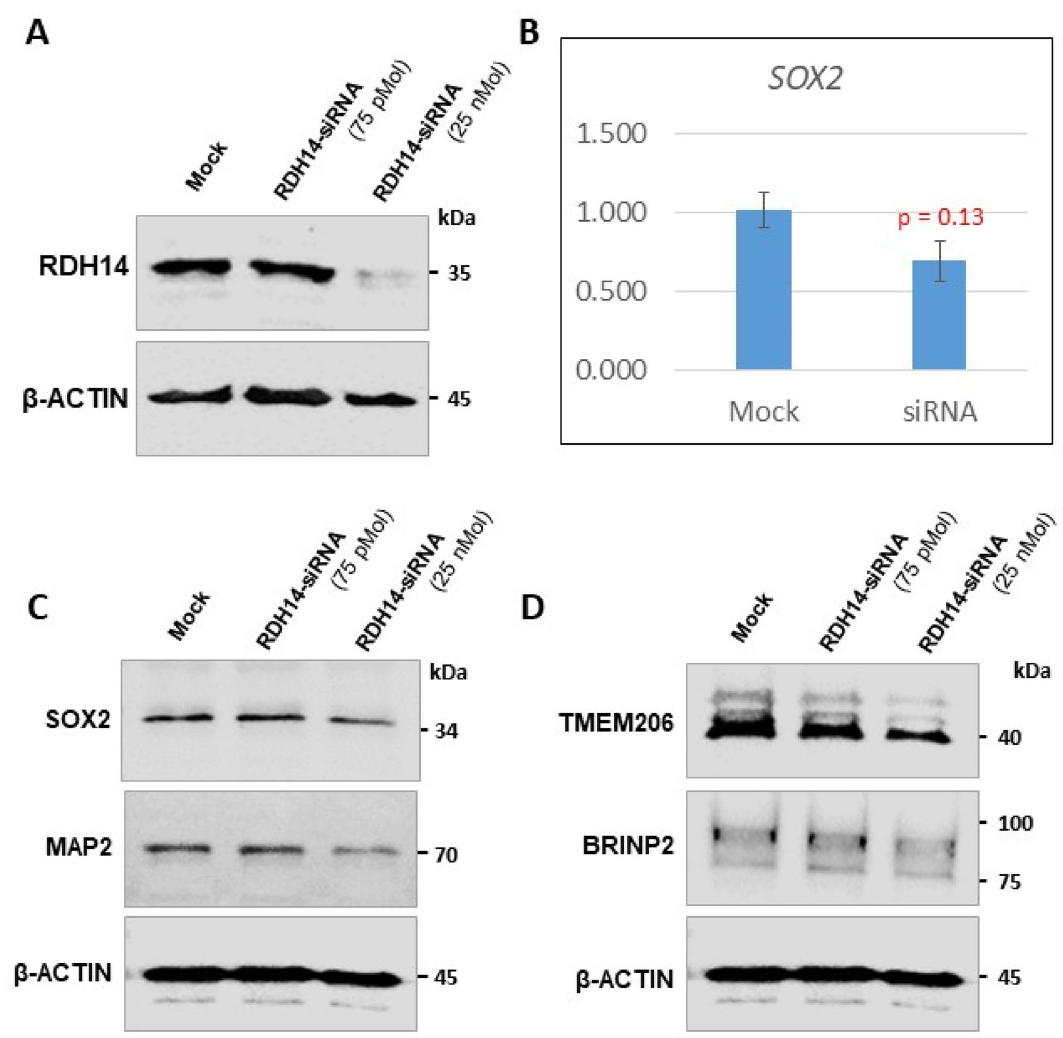
Figure 4. Analysis of the RDH14 knock down effects on SOX2, MAP2, TMEM206 (PACC1) and BRINP2 (FAM5B) in SK-N-SH cells. ( A ) Western blot analysis of the RDH14-siRNA transfection showing knock down of RDH14 protein, using anti-RDH14 rabbit polyclonal antibody (1:1000 dilution; cat# HPA056686; Atlas Antibodies, Bromma, Sweden). ( B ) qRT-PCR showing effect of RDH14-siRNA on transcription of SOX2 in SK-N-SH cells. ( C ) Representative western blot images showing the effects of RDH14 siRNA knock down on SOX2 and MAP2 protein levels using anti-SOX2 monoclonal antibody (1:2000 dilution; cat# ab79351, Abcam Inc, Toronto, ON), and anti-MAP2 polyclonal antibody (1:2000 dilution; cat# ab79351, Abcam Inc, Toronto, ON). ( D ) Effect of RDH14 siRNA knock down on TMEM206/PACC1 and FAM5B/BRINP2 protein levels using anti-TMEM206 rabbit polyclonal antibody (1:1000 dilution; cat# TA342366; Origene Tech., Rockville, MD), and anti-FAM5B rabbit polyclonal antibody (1:500 dilution; cat# orb474203; Biorbyt Tech., St Louis,